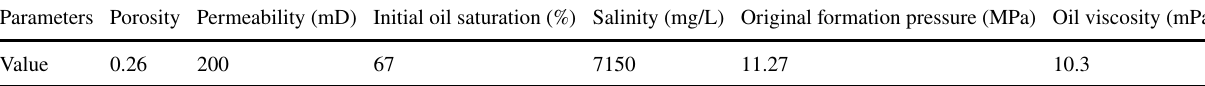
Table 2 The basic parameters of the reservoir